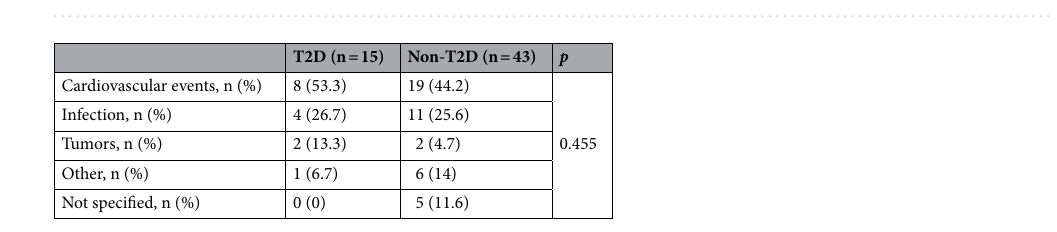
Table 3. Cause of death in waitlisted patients who not received KT according to T2D presence/absence.